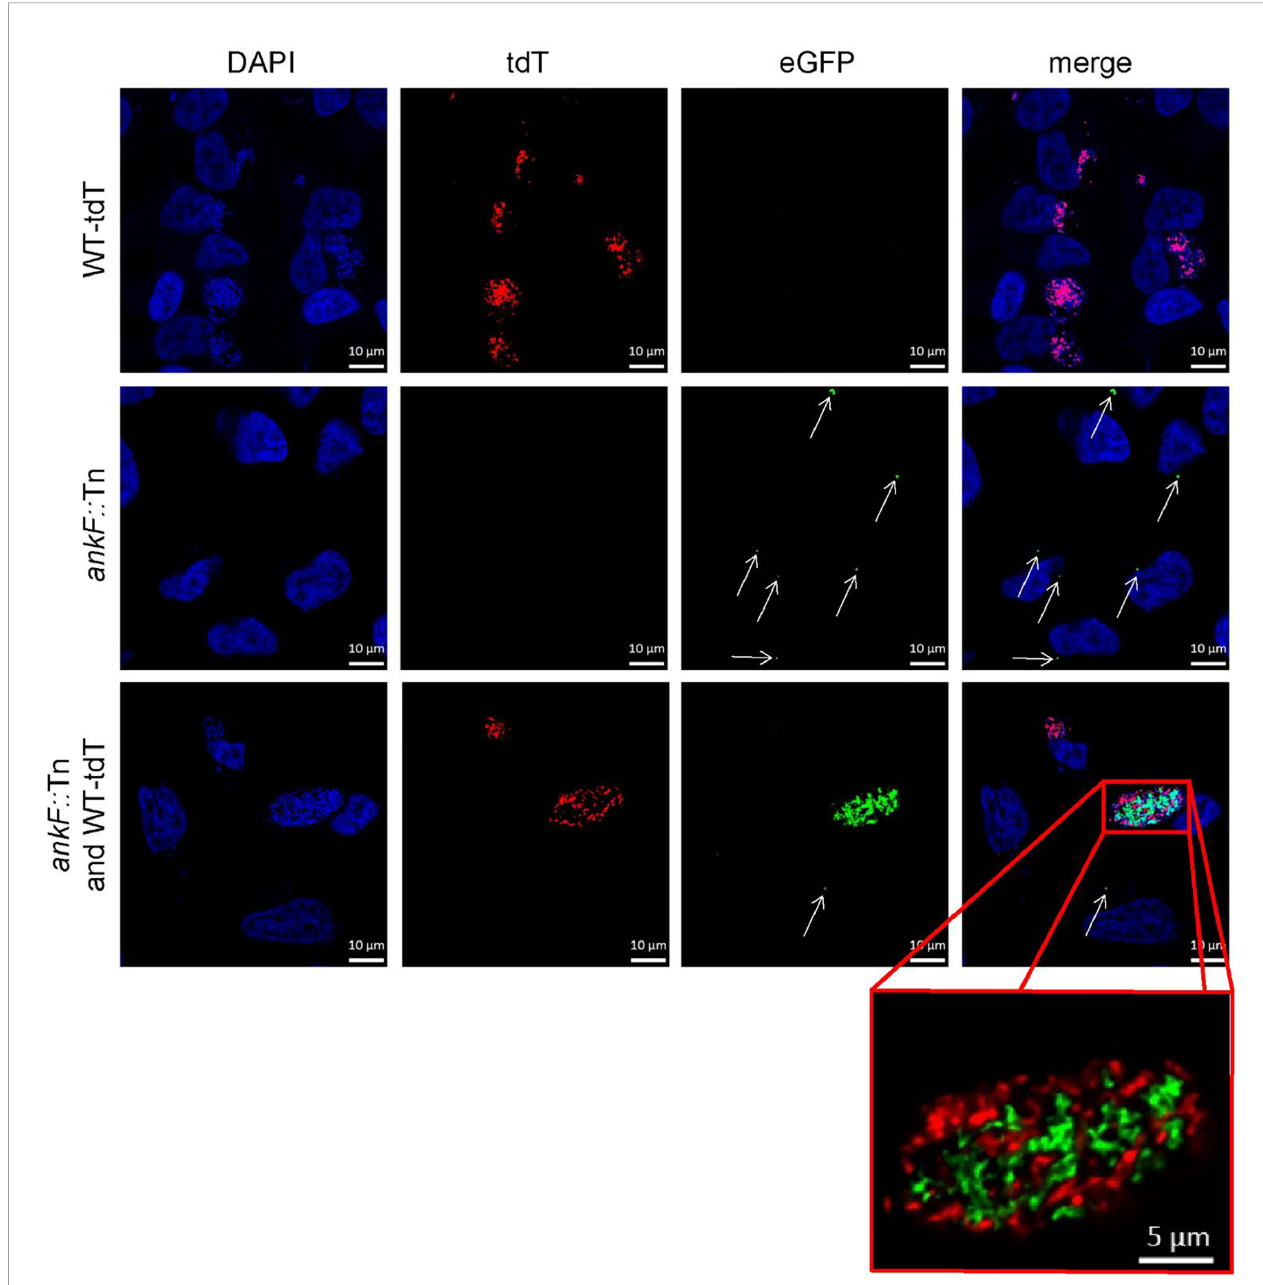
FIGURE 5 | The AnkF transposon mutant replicates inside a CCV harboring wild-type bacteria. HeLa cells were infected with C. burnetii expressing IPTG-inducible tdTomato (WT-tdT) in the presence of 2 mM IPTG and/or ankF ::Tn ( ankF ::Tn) endogenously expressing GFP at an MOI of 50 each as indicated. At 72 h post- infection, the cells were fi xed and nuclei and bacterial DNA was stained with DAPI (blue). Representative LSM images of two independent experiments are shown. A red box represents a close-up without DAPI staining of the merged image. White arrows indicate single ankF ::Tn